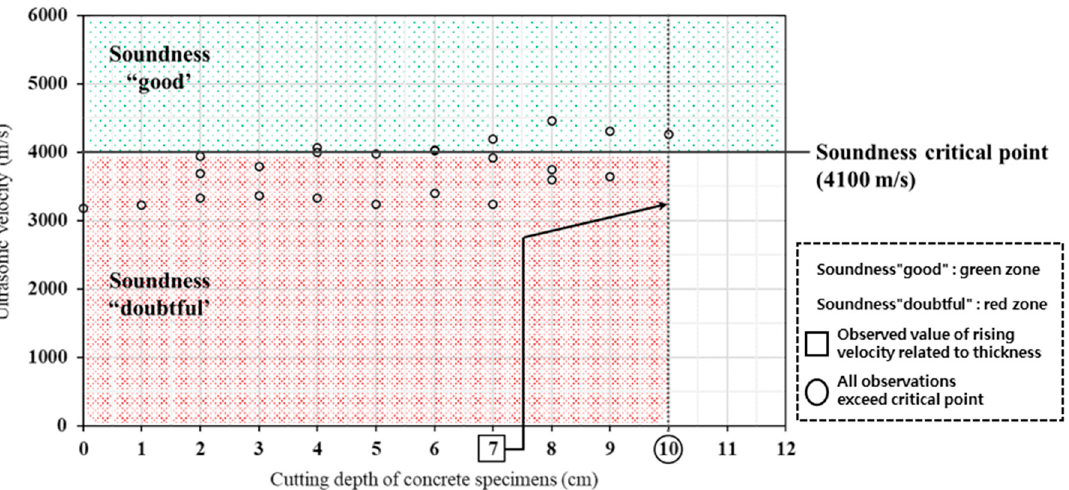
Figure 10. Ultrasonic velocity result according to the cutting thickness of the core specimens (Spalling severity with width section).